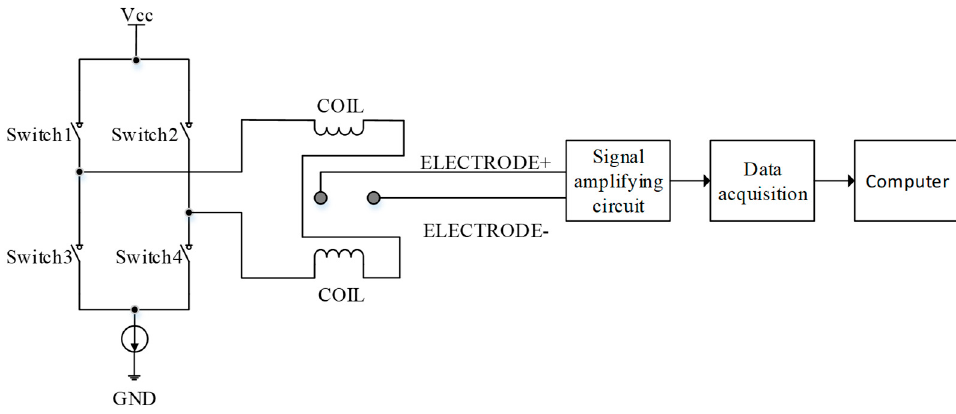
Figure 2. Acquisition system.